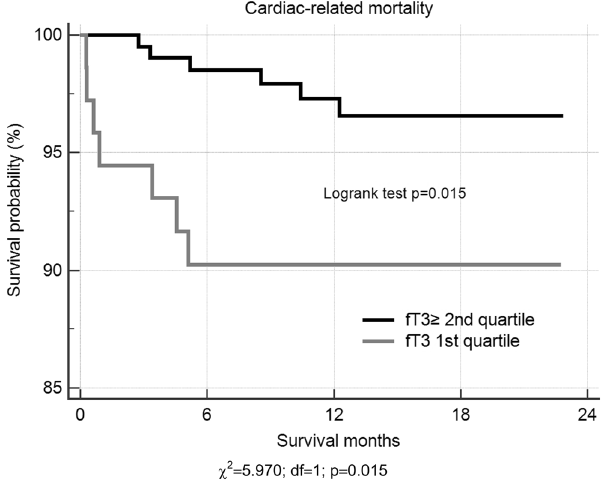
Figure 1. Two year Kaplan-Meier survival curves for cardiac-related death in patients with AMI stratified on fT3 quartiles. A log-rank test was used to compare survival curves.